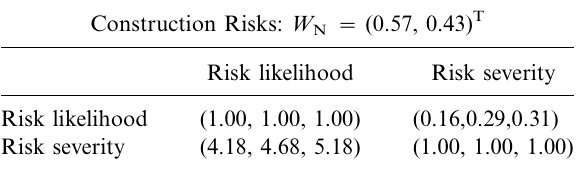
Table 10. (Level 1) Matrices of pairwise comparisons and respective normalized weigh